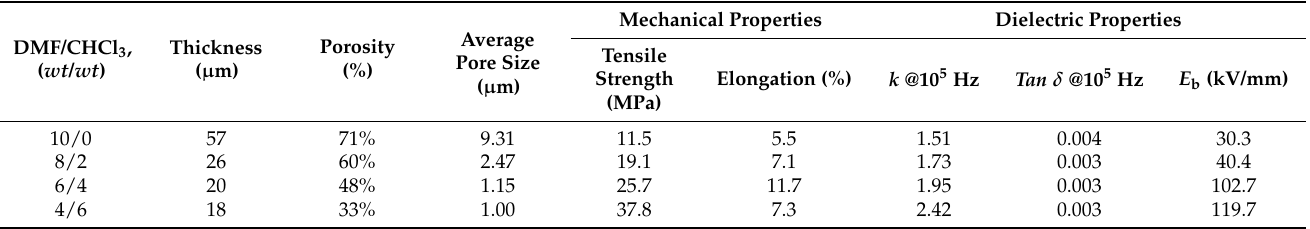
Table 1. Porosity as well as mechanical and dielectric properties of the porous sPI films.